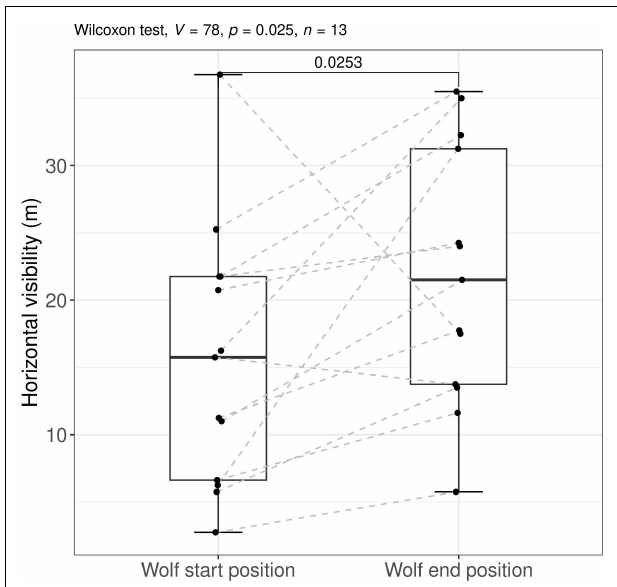
FIGURE 5 | Distribution of the horizontal visibility (in meters) at the wolf start position (WSP) and the wolf end position. The difference in horizontal visibility tested by a non-parametric Wilcoxon signed rank tests. The gray dashed lines indicate paired observations. Observations are based on experimental approach trials by humans on wolves in south-central Scandinavia,